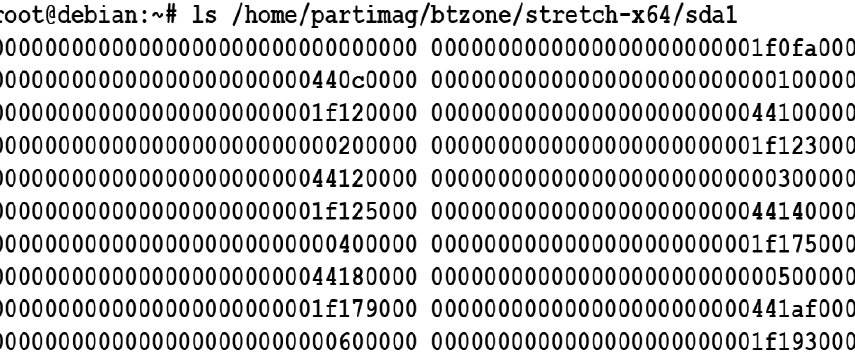
Figure 6. The proposed image format for the FSBT mechanism.